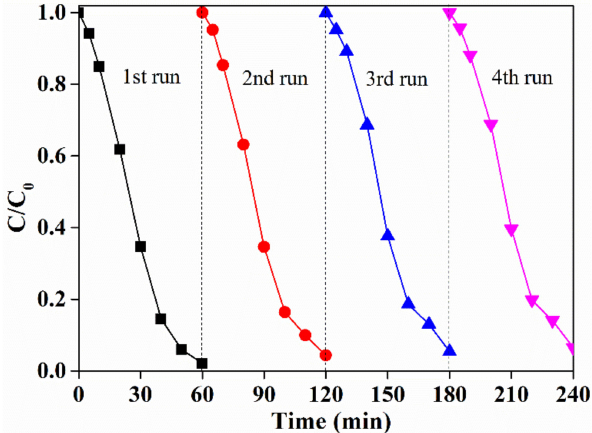
Figure 7. Reusability of LaCoO 3 . LaCoO 3 = 20 mg / L, SMX = 50 µ M, PAA = 660 µ M, pH 7.0, 25 ◦ C. black square: 1st run, red circle: 2nd run, blue up triangle: 3rd run, magenta down triangle: 4th